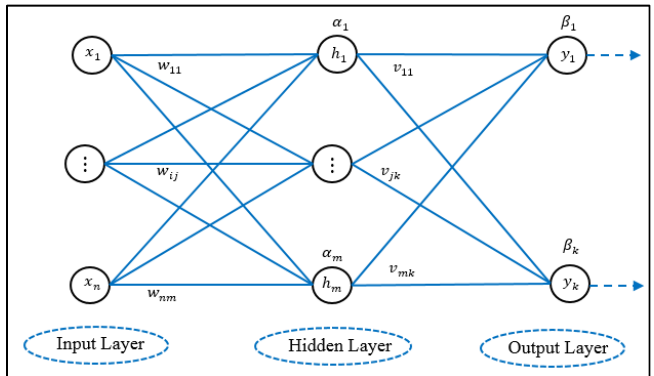
Figure 3. Structure diagram of the BP neural network.